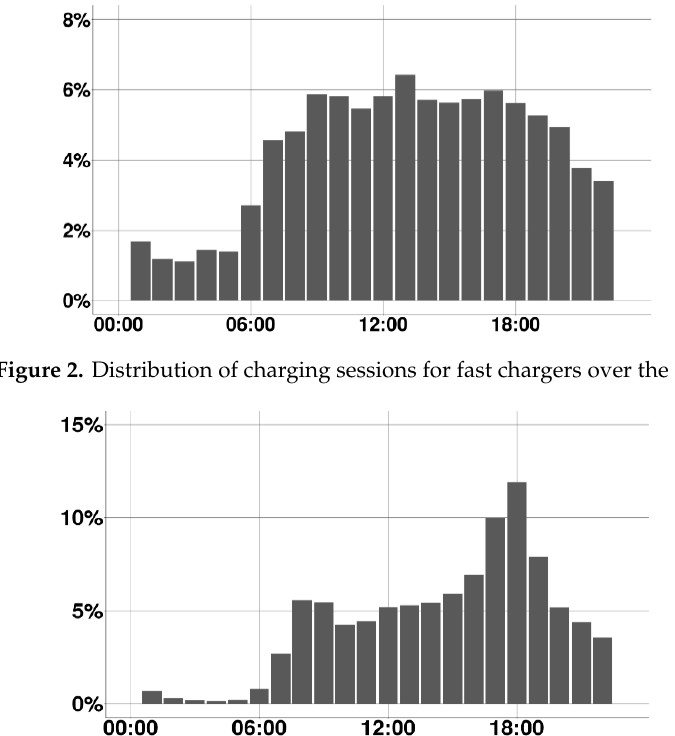
Figure 3. Distribution of charging sessions for level 2 chargers over the day.